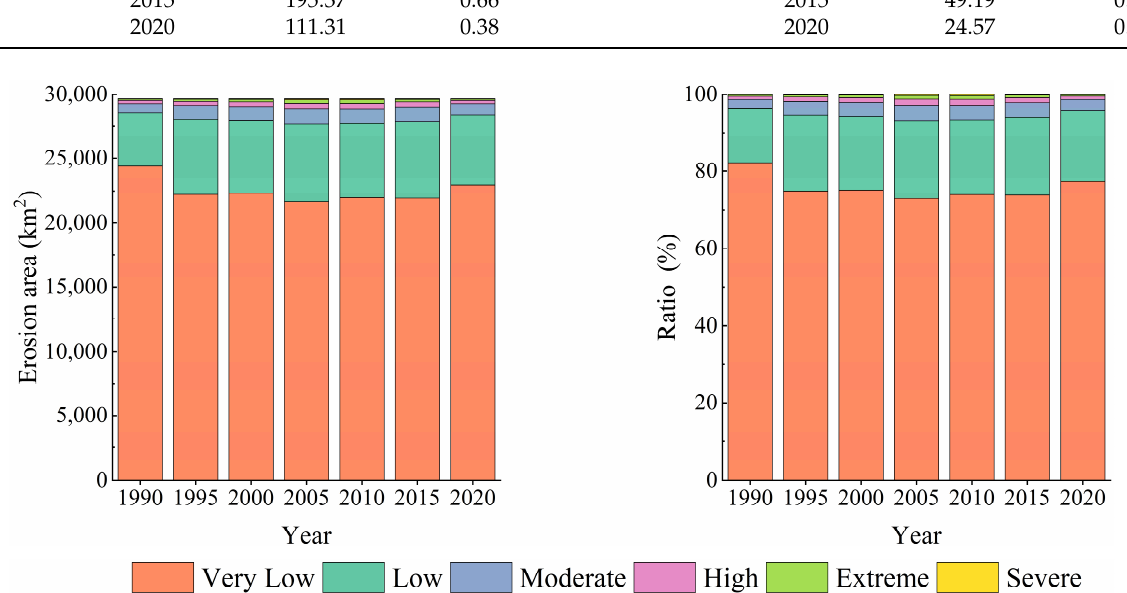
Figure 5. The total amount of SE and its area ratio in the QLB from 1990 to 2020.